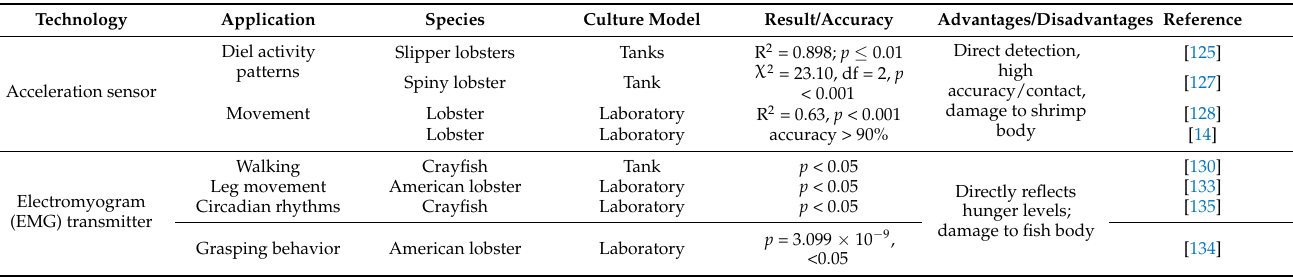
Table 3. Summary of methods based on movement sensors.